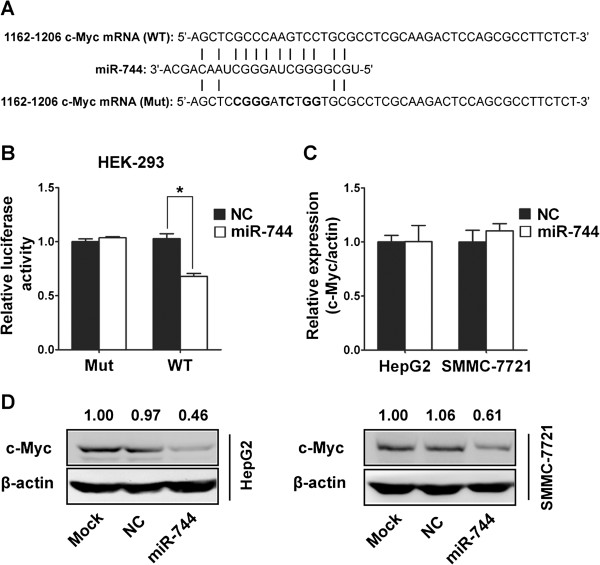
miR-744 directly targets and regulates c-Myc expression in HCC cells. (A) Wild-type (WT) and mutant (Mut) of putative miR-744 targeting sequences in c-Myc mRNA. Mutant sequences were shown in bold type. (B) Analysis of luciferase activity. HEK-293 cells were cotransfected with miR-744 mimics or control oligo nucleotides, pRL-TK and firefly luciferase reporter plasmid containing putative miR-744 targeting sequences of c-Myc. pRL-TK was cotransfected as an internal control to correct the differences in both transfection and harvest efficiencies. The firefly luciferase activity of each sample was normalized to the Renilla luciferase activity. The normalized luciferase activity control oligo nucleotides was set as relative luciferase activity 1 respectively. (C) Effects of miR-744 mimics on the endogenous c-Myc mRNA levels. HepG2 and SMMC-7721 cells were cotransfected with miR-744 mimics or negative control oligonucleotides. Forty-eight hours after transfection, cells were isolated, the expression of c-Myc was analyzed by qRT-PCR. (D) Effects of miR-744 on the endogenous c-Myc protein levels. Forty-eight hours after transfection with the miR-744 mimics or negative control oligonucleotides, HepG2 and SMMC-7721 cells were analyzed by Western blotting, with β-actin as an internal control. The value up each lane indicates the c-Myc expression in oligonucleotides-transfected cells compared with mock-transfected (with only transfection reagent) cells. The data were subjected to Student's t-test. *p < 0.05, **p < 0.01. NC, negative control oligonucleotides.